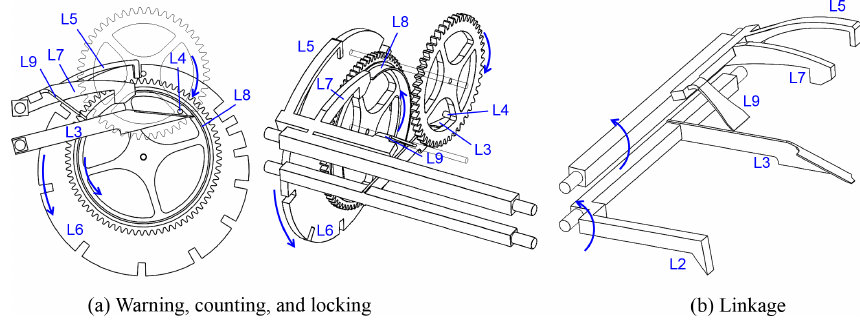
Figure 23. Structure and operation of the N8 striking trigger. (The trigger is similar to that of N5.)